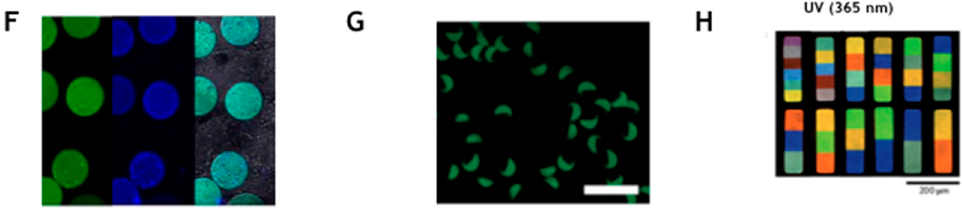
Figure 2. Microgel and Hydrogel Particle production by batch synthesis and microfluidics. ( A ) Core/shell microgel synthesis by multistep combination of precipitation and seed polymerization: the formation mechanism of microgels from the aggregation of precursor nanoparticles to the realization of ( B ) a spectral encoding system on microgels by copolymerization in different compartments of two different dyes. Emulsification in microfluidics through Droplet Generation systems: ( C ) simple T-junction and flow-focusing; ( D ) combination of multiple flow-focusing to obtain poly(ethylene glycol) diacrylate (PEGDA)-based TMV Janus microparticles; ( E ) Continuous flow lithography for the realization complex shaped hydrogel microparticles; ( F ) Hydrogel microparticles obtained by droplet generation; (G) encoding by Janus PEGDA hydrogels microparticles; and ( H ) graphical and spectral encoding combination on PEGDA microparticles obtained by flow lithography approach. ( A ) reprinted with permission from [36], copyright 2016 Wiley; ( B ) adapted with permission from [38],